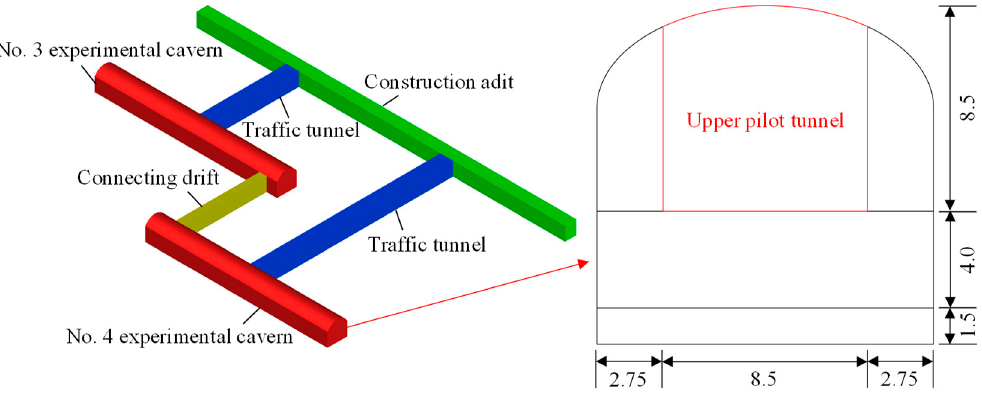
Figure 11. Layout of the CJPL and cross-section of No. 4 experimental cavern (unit: m).